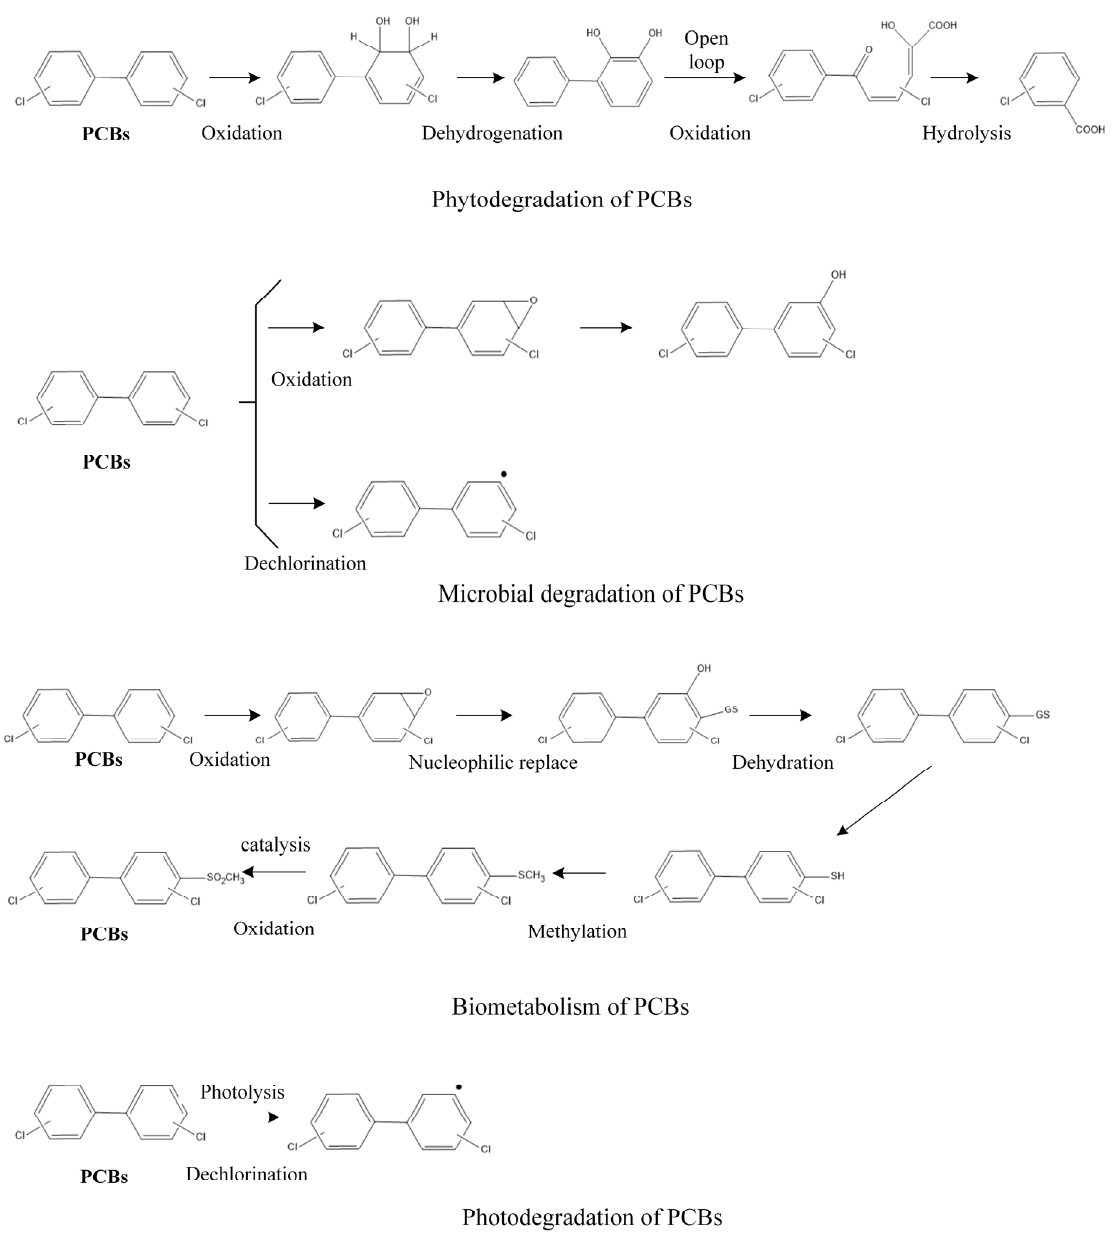
Figure 1. Schematic diagram of the four degradation or metabolic pathways of the